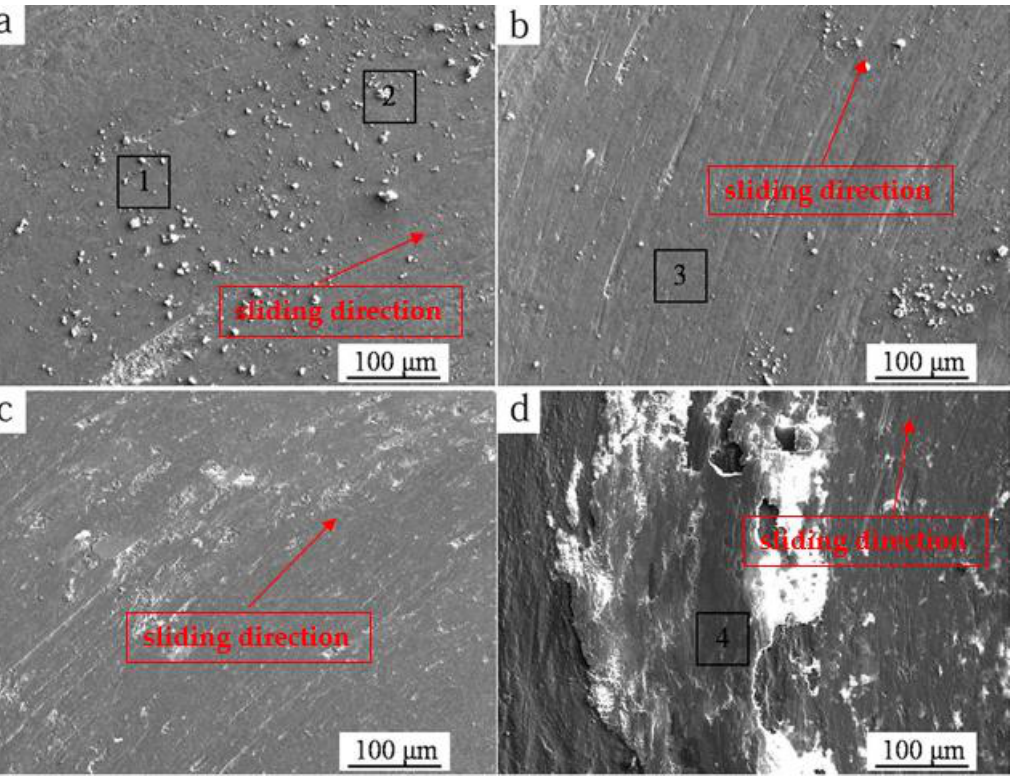
Figure 6. The wear morphology of samples 4# at different loading ( a ) 3 N. ( b ) 4 N. ( c ) 5 N. ( d ) 10 N.